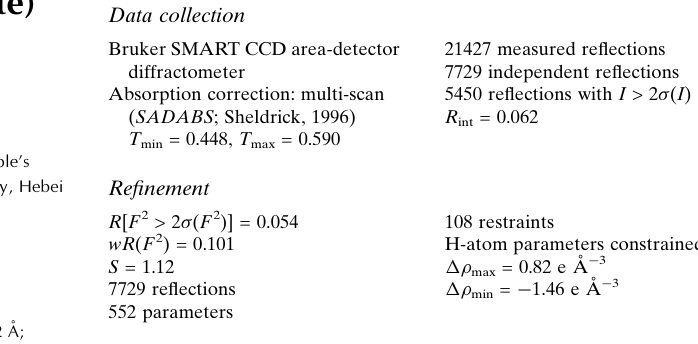
Bruker SMART CCD area-detector diffractometer